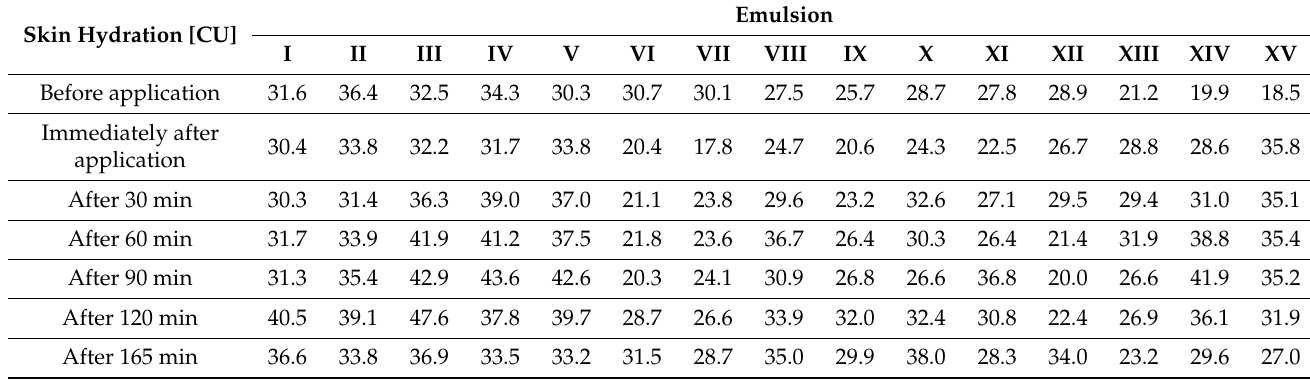
Table 4. Results of skin hydration before application of emulsions I–XV, immediately after application and consecutively after 30, 60, 90, 120, and 165